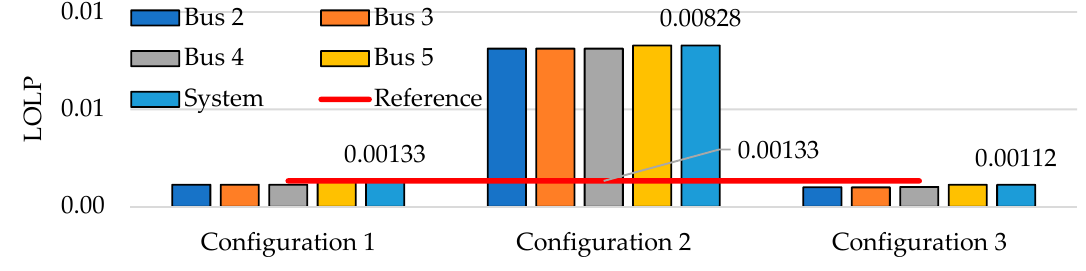
Figure 8. Impacts of wind and energy storage on operational adequacy.